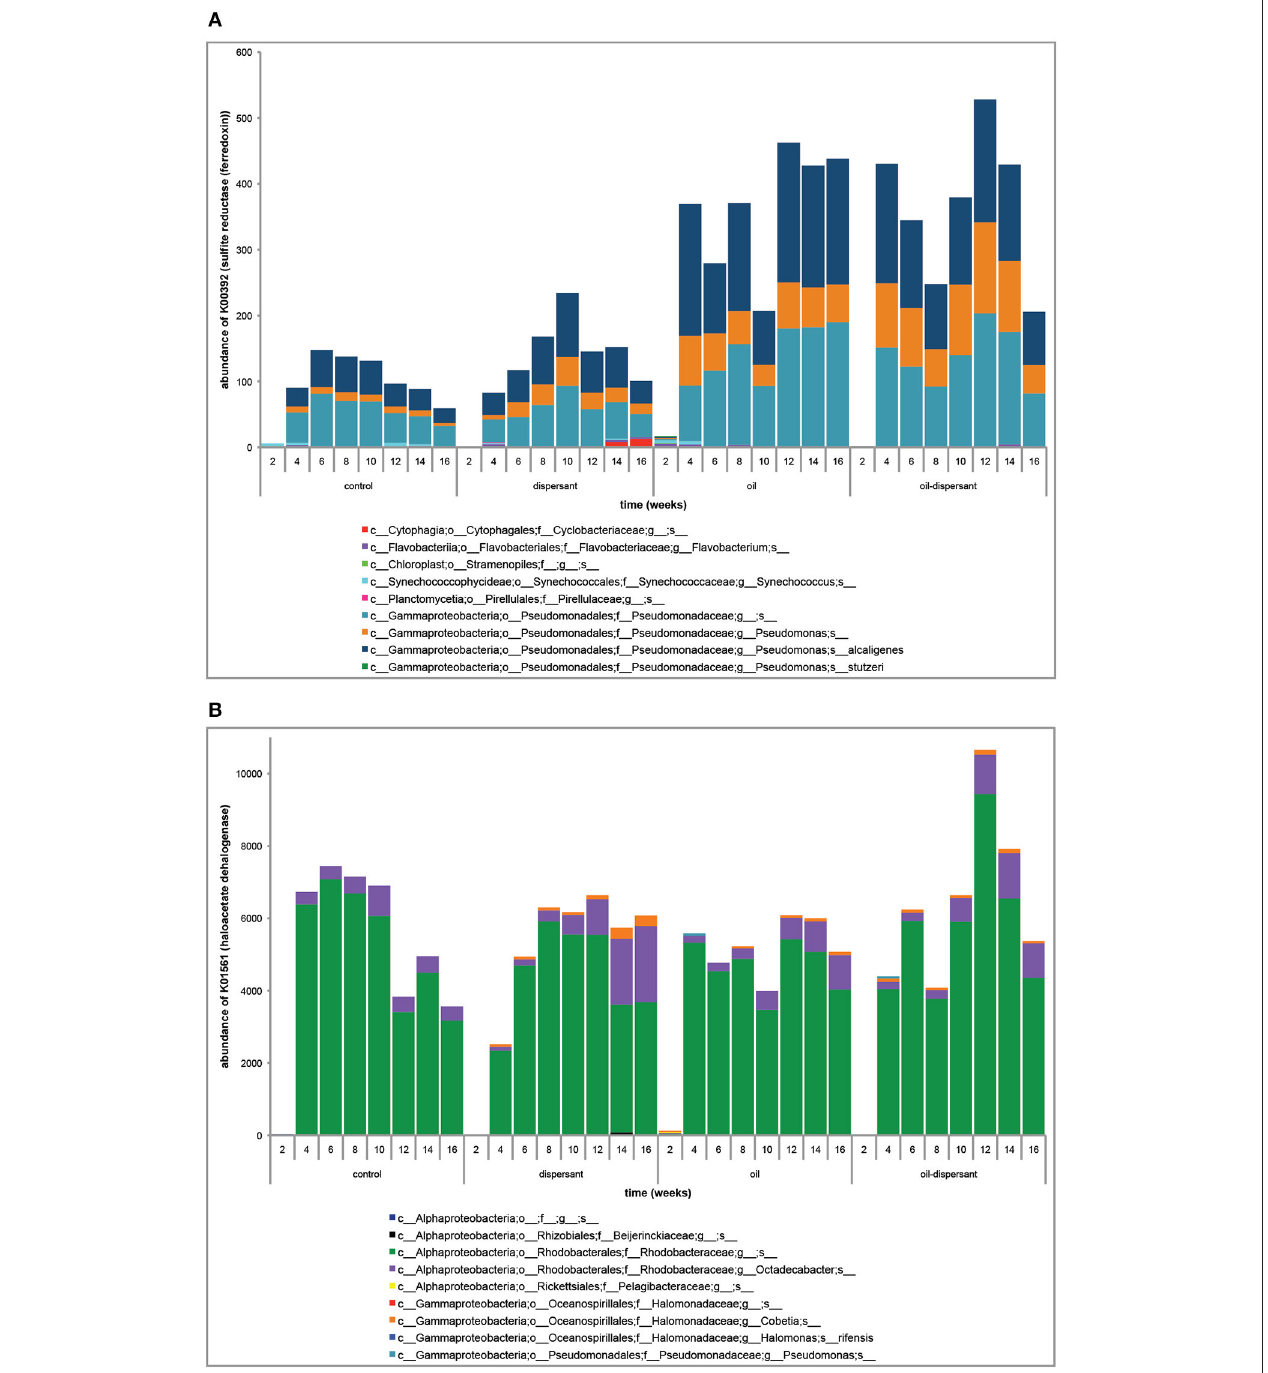
FIGURE 4 | (A) The abundance of K00392 [sulfite reductase (ferredoxin)] and predicted metagenome contributions of individual bacterial phylotypes ( > 1% of total) across treatments and over time. (B) The abundance of K01561 (haloacetate dehalogenase) and predicted metagenome contributions of individual bacterial phylotypes ( > 1% of total) across treatments and over time.